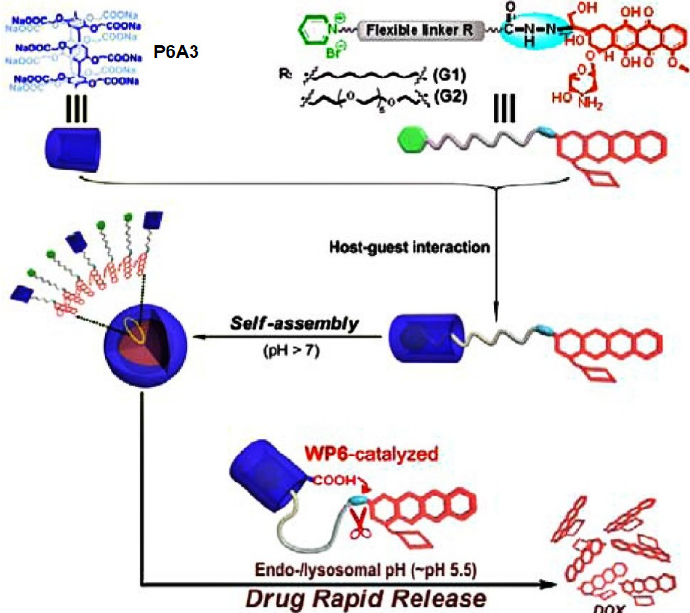
Figure 12. Schematic representation of the construction of the pH -controlled drug delivery system based on P6As. Reproduced with the permission of reference [91]. Copyright © American Chemical Society 2015.